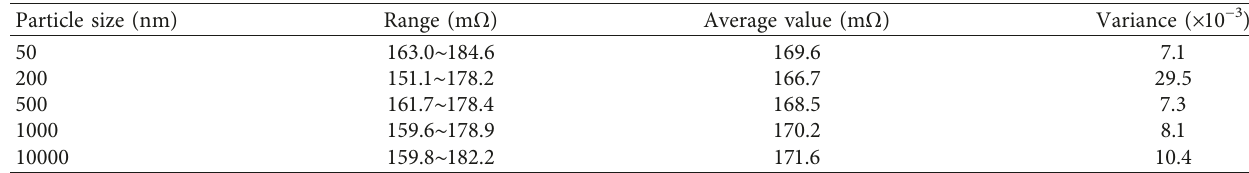
Table 6: The arc energy of Ag-SnO